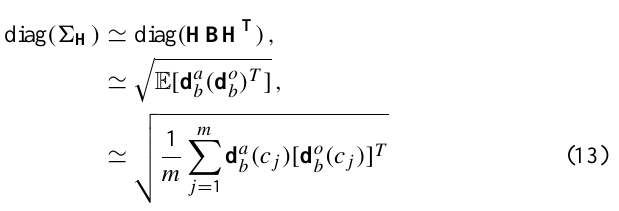
Fig. 9. Surface ozone concentration (in ppb) on the 7 July 2010 at 14:00:00 UTC for the (d) S TD simulation, (e) L XY simulation, (f) S TD L XY simulation